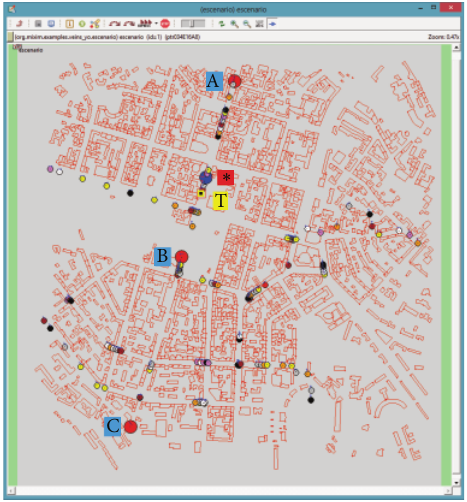
Figure 1: Vehicular network scenario in OMNeT++ (red circles A, B, C = RSUs//blue circle ∗ = video client//yellow square T = background traffic source//small circles = other vehicles//red rectangles =